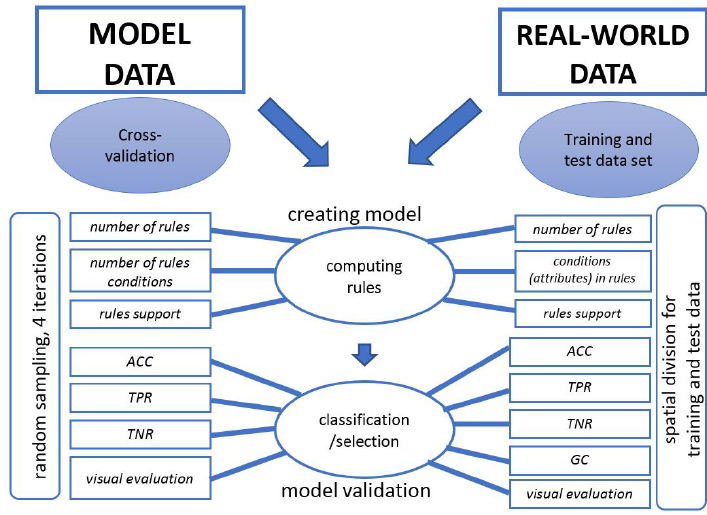
Fig. 3. Scheme of research on model and real data (source: A. Fiedukowicz